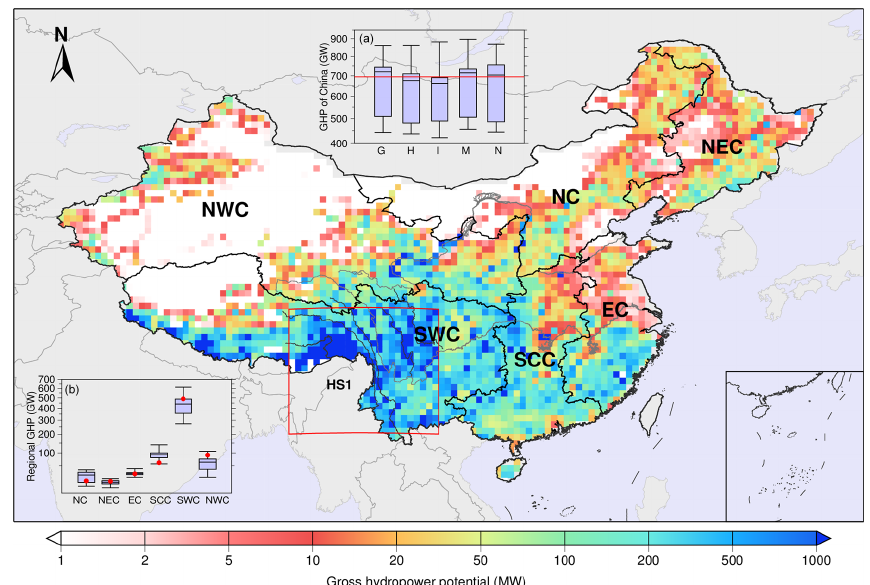
Figure 2. Medians of the GHPs of China across the ensemble of all GCM-GHM combinations over the historical period (1971–2000). The red rectangular denotes a hotspot region (HS1). NC: north China, NEC: northeast China, EC: east China, SCC: south central China, NWC: northwest China, SWC: southwest China. Inner plot (a) shows the boxplot of GHP of China across GHMs for each GCM, where the red line is the reported GHP, i.e., 694GW, and G, H, I, M, and N denote GFDL-ESM2M, HadGEM2-ES, IPSL-CM5A-LR, MIROC-ESM-CHEM, and NorESM1-M, respectively. The inner plot (b) shows the boxplot of regional GHPs across all GCM-GHM combinations on a log scale, where red dots denote reported GHPs (Li and Shi, 2006).